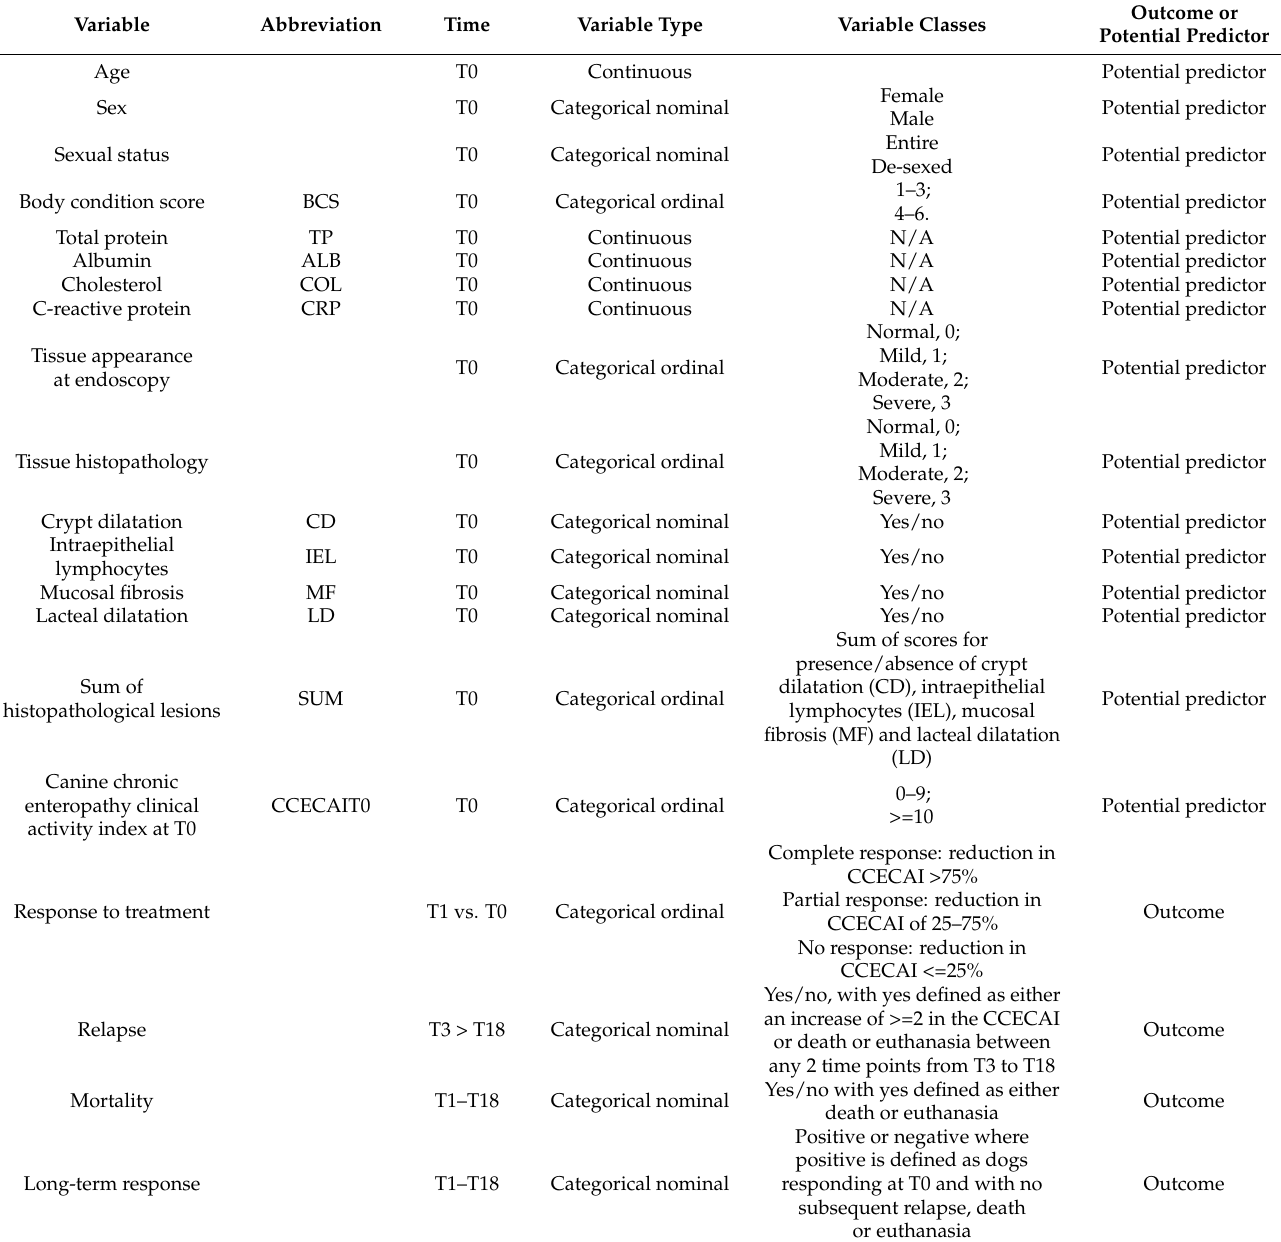
Table 1. Summary of abbreviations, time of evaluation, variables type and class of the variables included in the